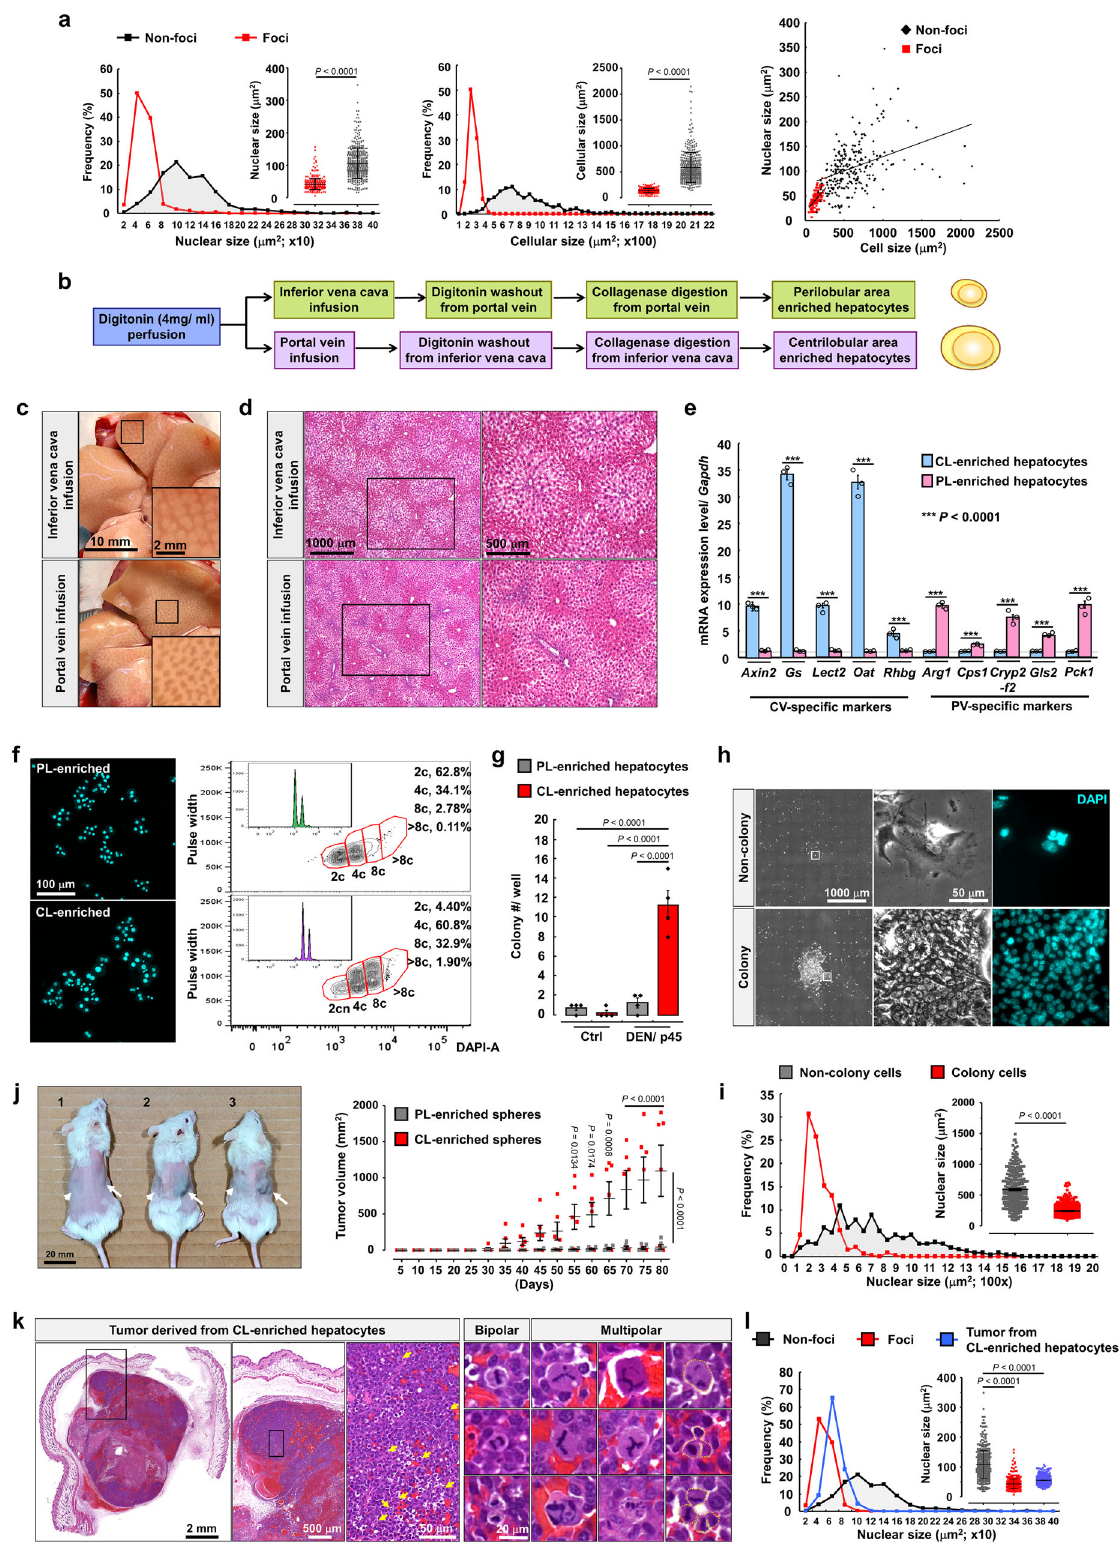
with AZD1152 showing a signi fi cant time-course effect (Fig. 6a – c). This result suggested that the level of pT232-AURKB plays a critical role in controlling hyperpolyploidization of hepatocytes.